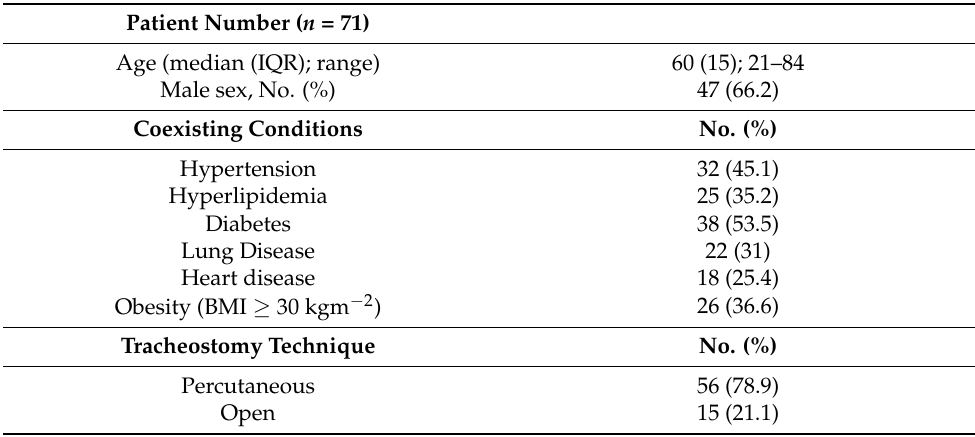
Table 1. Patient demographics, comorbidities and tracheotomy summary data.